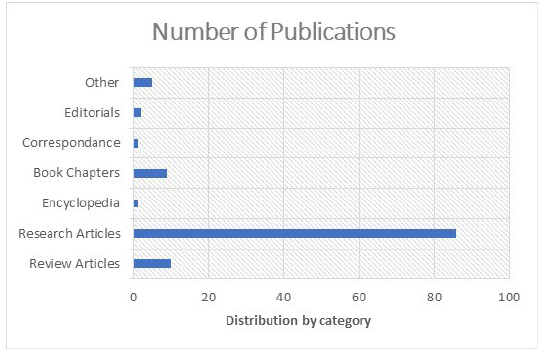
Figure 3. Publications in springer.